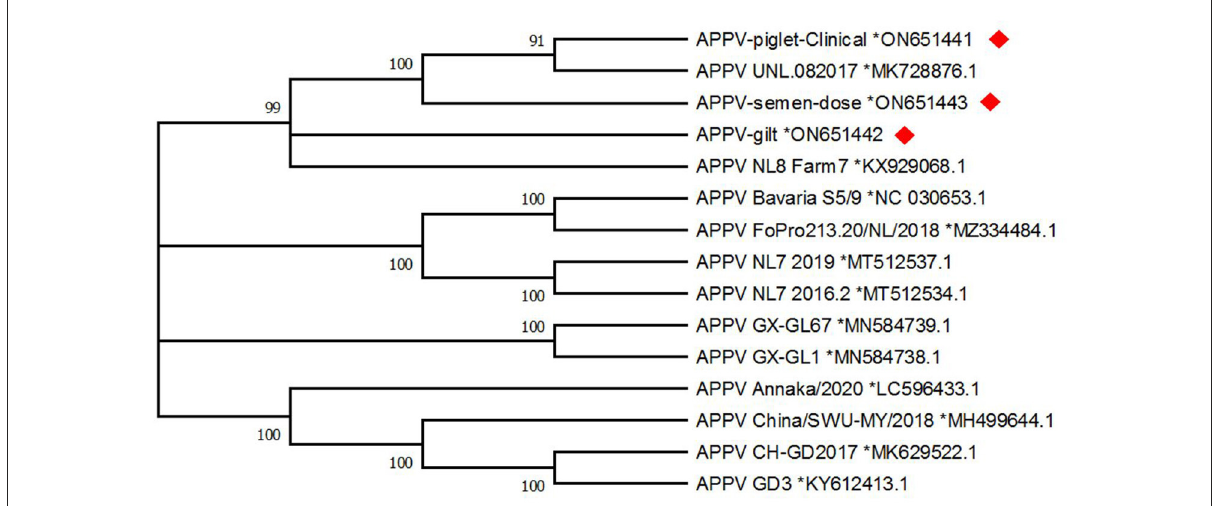
FIGURE3 Maximum likelihood phylogenetic tree generated with 1,000 bootstrap replicates (MEGA-X) for atypical porcine pestivirus E2; evolutionary history was inferred by using the maximum likelihood method and Tamura-Nei model. Sequences from this study, designated with a red diamond were obtained from a semen dose, serum from a clinically affected piglet, and serum from an incoming gilt. Reference sequences are named by isolate name and Genbank reference number listed after the black asterisk. Frequencies for a branch that are below 70% are not